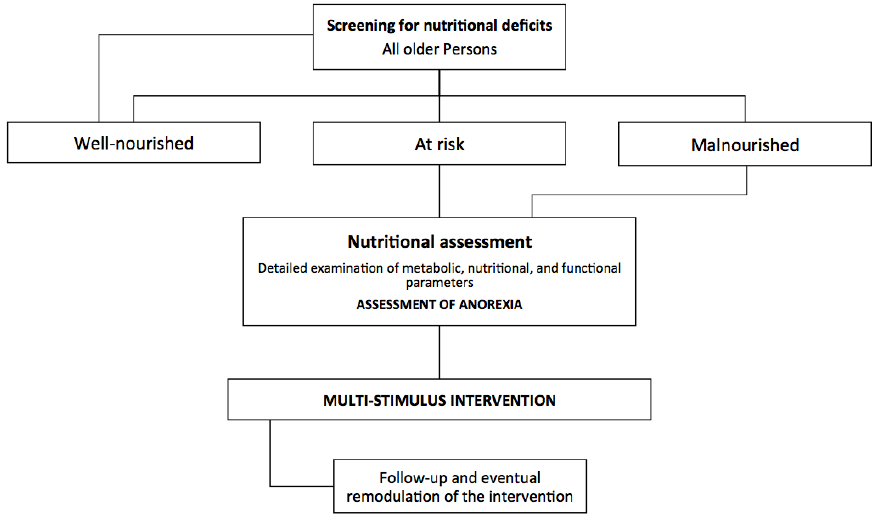
Figure 4. Assessment of anorexia of aging and malnutrition.